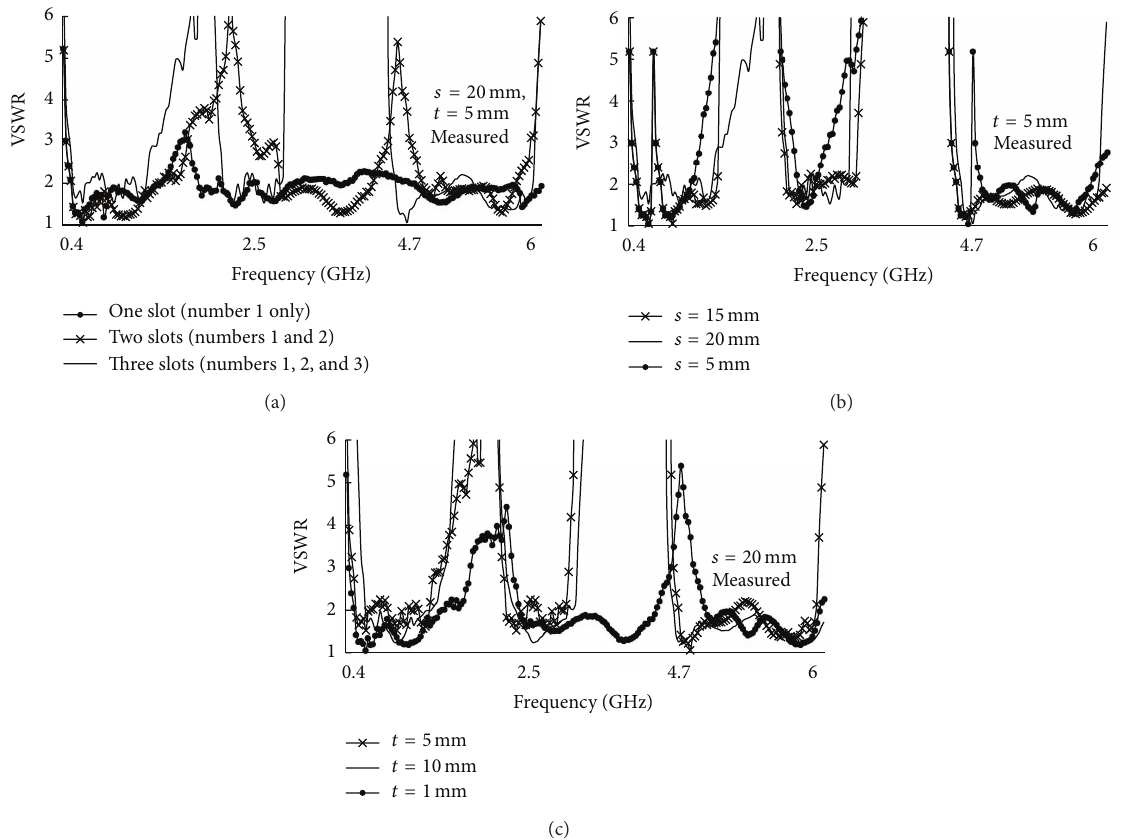
Figure 6: Measured VSWR as a function of (a) the inserting-slot numbers, (b) the inserting-slot length ( 𝑠 ), and (c) the inserting-slot width ( 𝑡 ). Other dimensions are the same as given in Figure